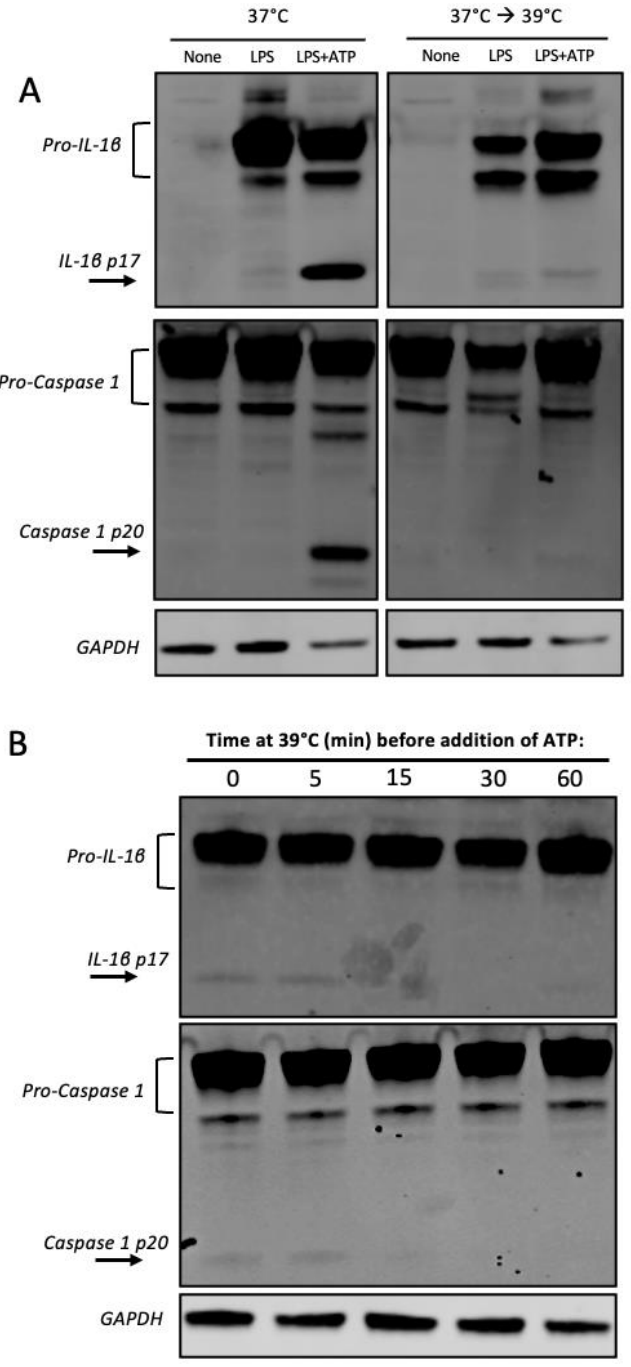
Figure 3. Mild heat shock rapidly inhibits caspase 1 and IL-1β processing. ( A ) Western blot shows presence of IL-1β processed fragment p17 and caspase 1 processed fragment p20 in LPS primed iBMMs treated with ATP incubated at 37 °C (Left panels), and decreased processing in heat-exposed cells (Right panels). ( B ) Time course: cells were primed for 3 h with LPS at 37 °C, then exposed to 39 °C for the indicated times, followed by addition of ATP to activate the processing of IL-1β. One of two independent experiments.